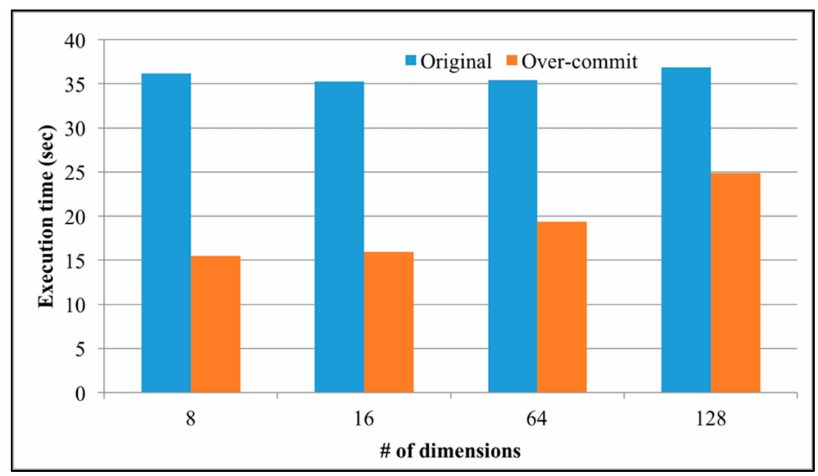
Figure 12. Execution time of executing SparkLR without over-committed resources and with 64 over-committed vCPUs.